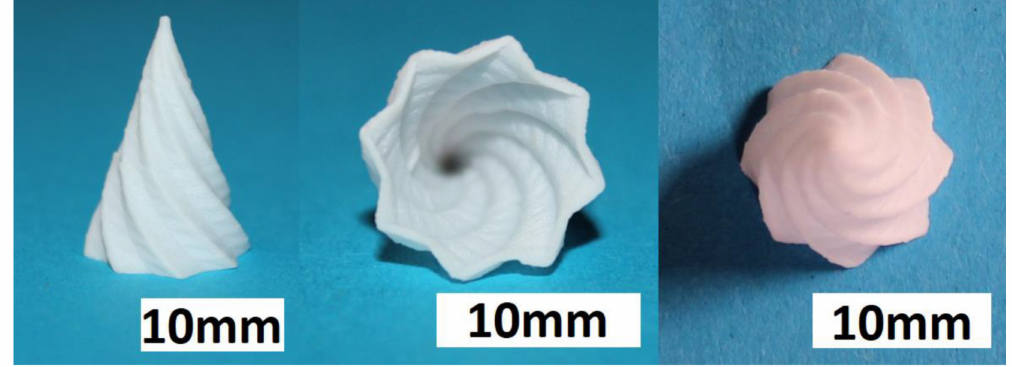
Figure 14. Sintered zirconia test component additively manufactured by thermoplastic 3D printing (T3DP) with 36 vol.-% zirconia particles in the suspension and without PFA; three different views.